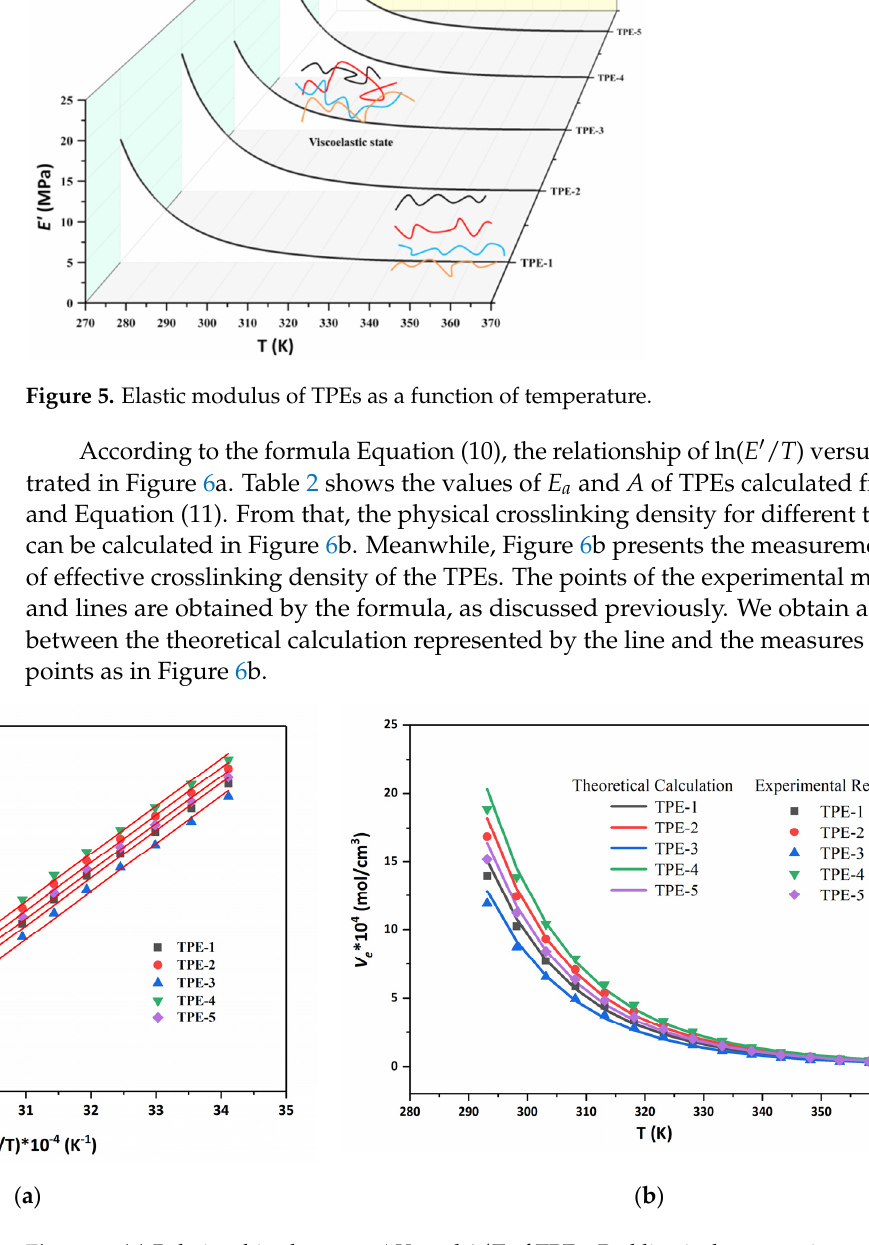
Figure 4. TPEs, TSEs and pseudo-semi IPN s sample FTIR spectra.